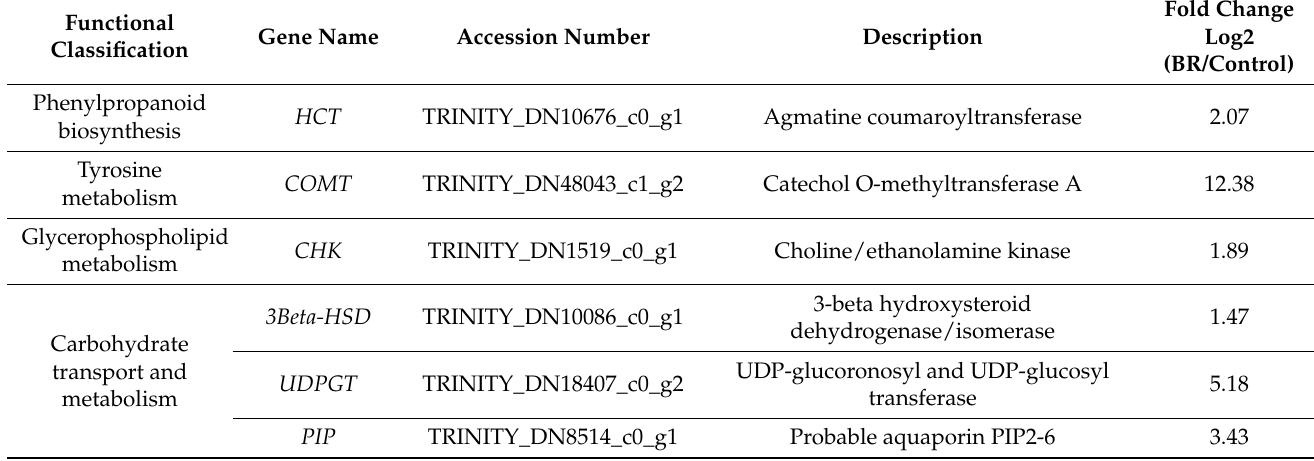
Table 2. Important upregulated genes in biosynthesis and metabolism of cell wall components.